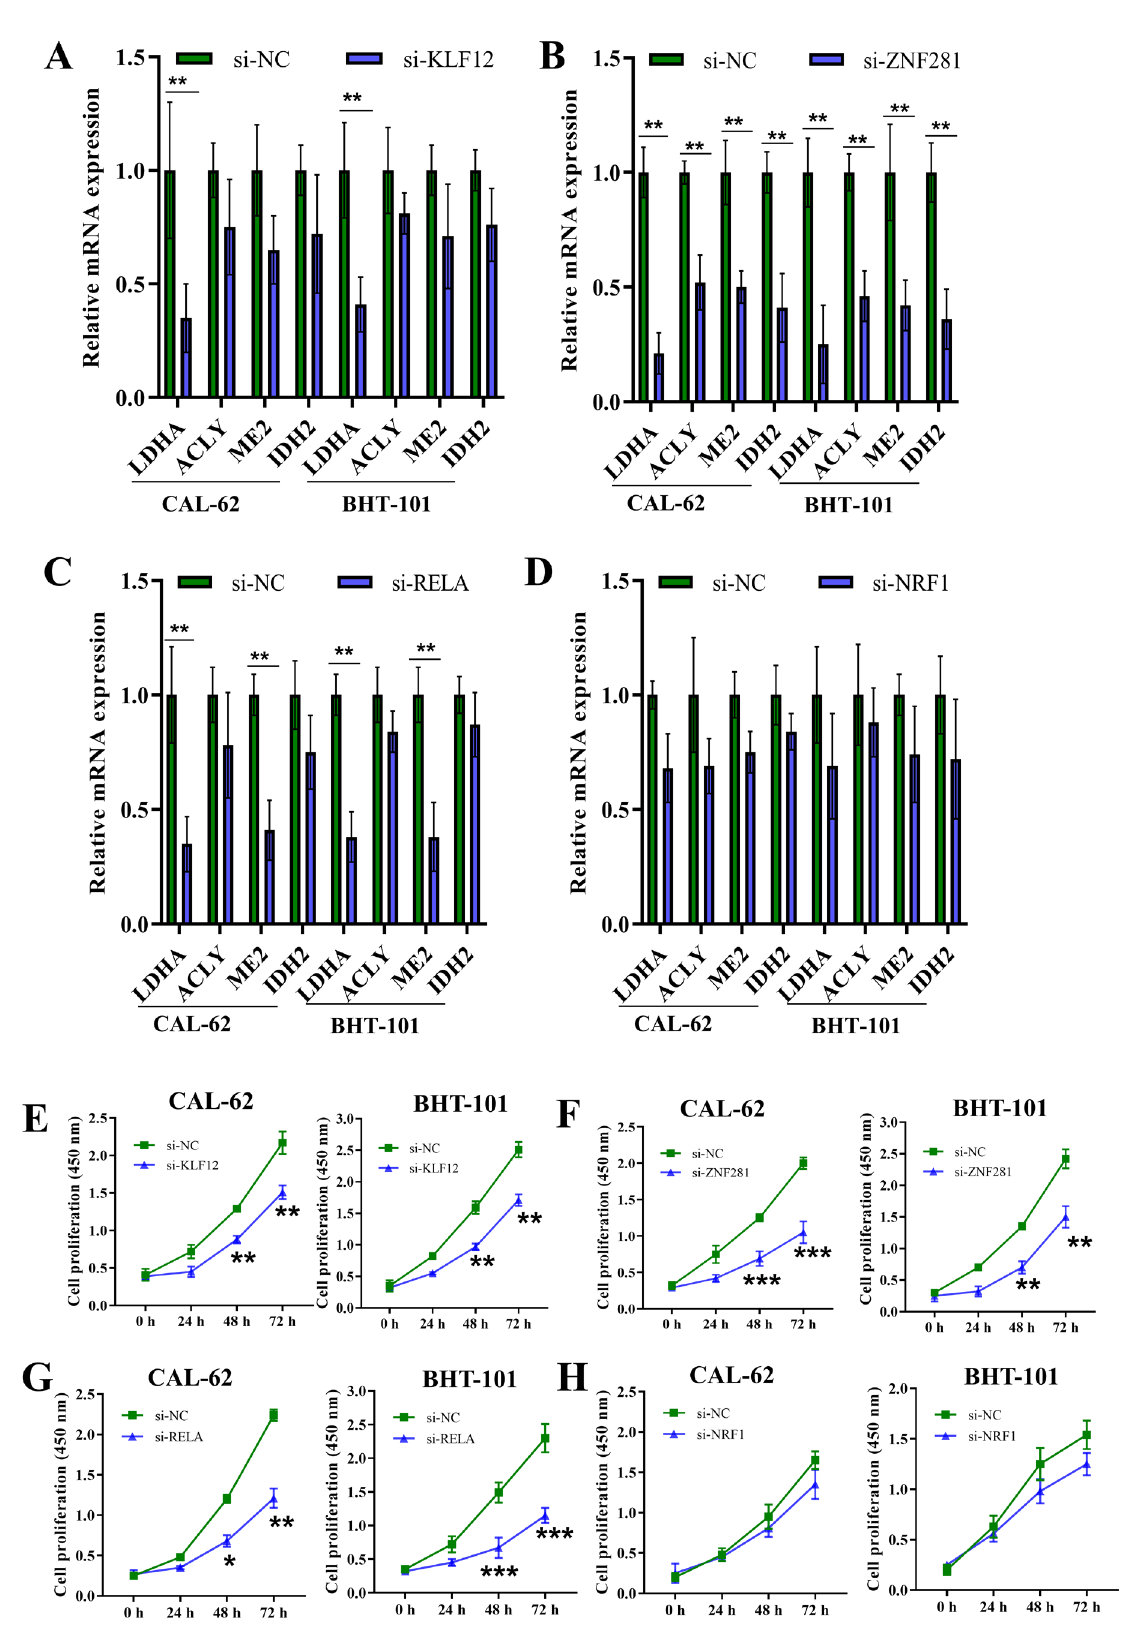
Figure 8. Effects of KLF12, ZNF281, RELA and NRF1 silencing on the expression of super-enhancer-controlled genes related to glucose metabolism and proliferation of PDTC cells. (A-D) Transcription of four representative genes (LDHA, ACLY, ME2 and IDH2) was detected using qRT-PCR after KLF12 (A), ZNF281 (B), RELA (C) and NRF1 (D) silencing. (E-H) Effects of KLF12 (E), ZNF281 (F), RELA (G) and NRF1 (H) silencing on cell proliferation was assessed using CCK8. ANOVA followed by Tukey’s post hoc test and Student’s t -test were used for statistical analysis. *P<0.05, **P<0.01,